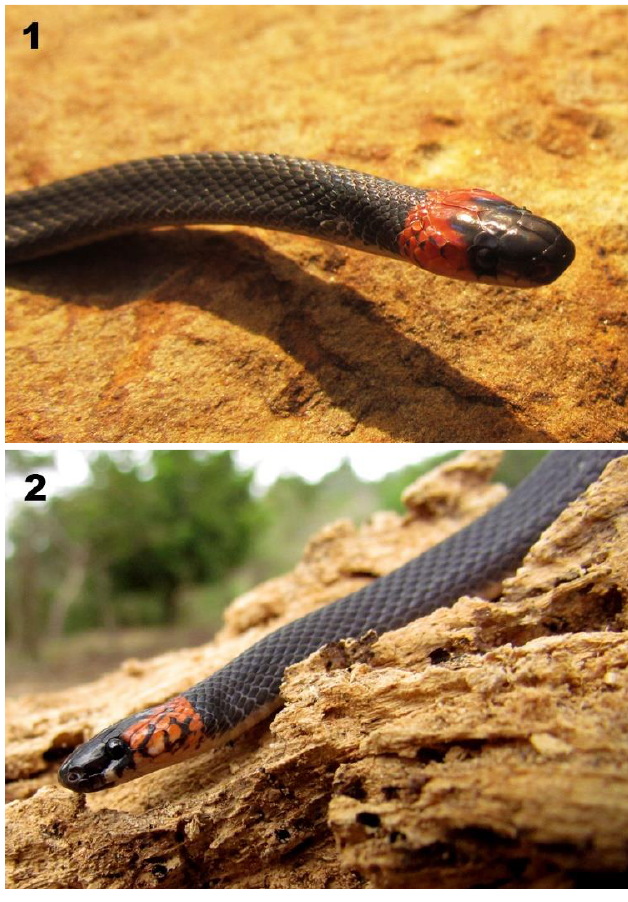
Figure 1–2. Specimens of Ninia atrata from San Salvador Valley in the northern foothills of the Sierra Nevada de Santa Marta, La Guajira